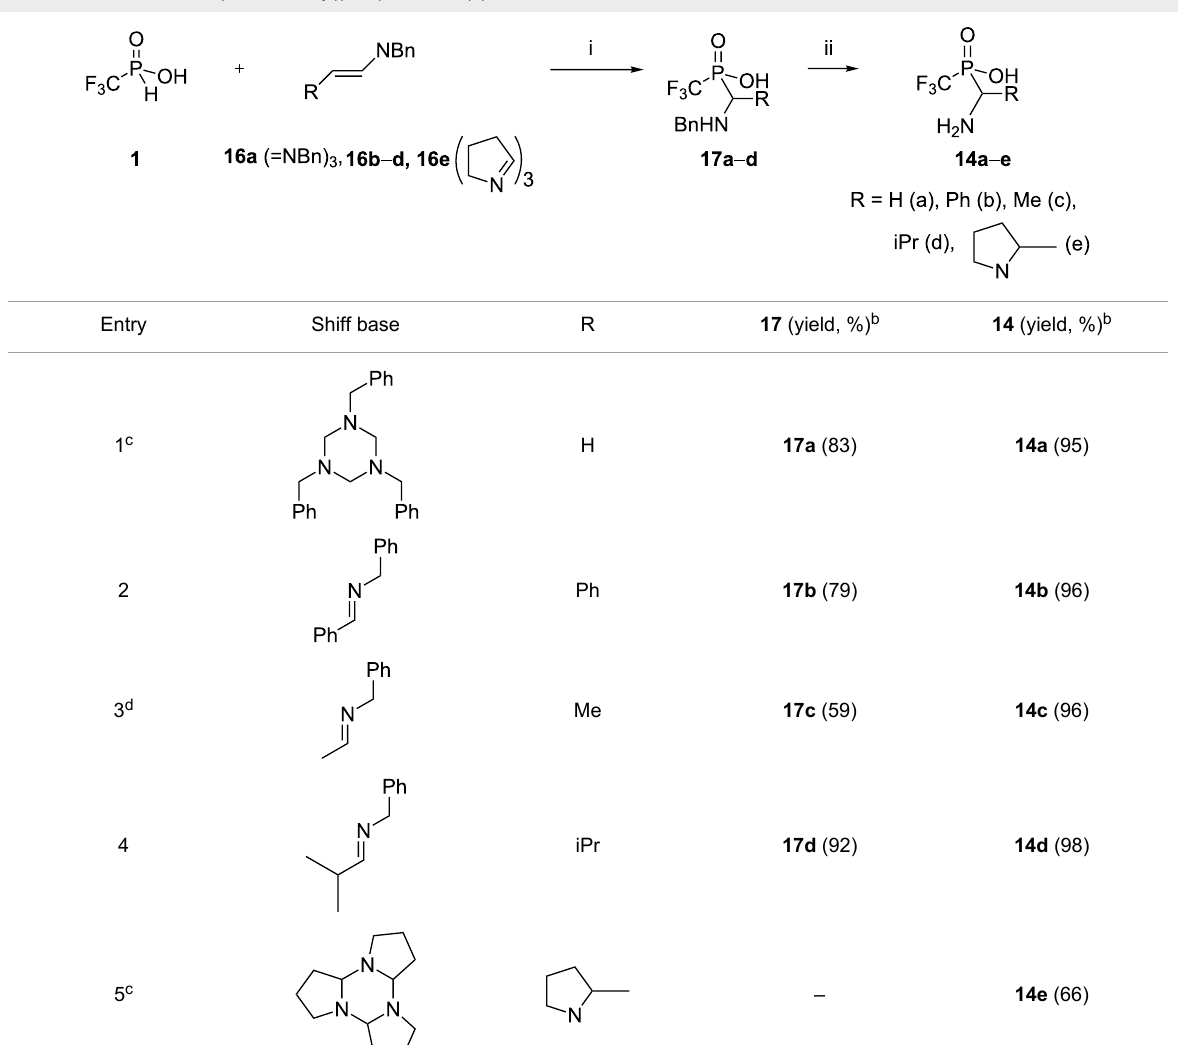
Table 1: The interaction of (trifluoromethyl)phosphinic acid ( 1 ) with Shiff bases.